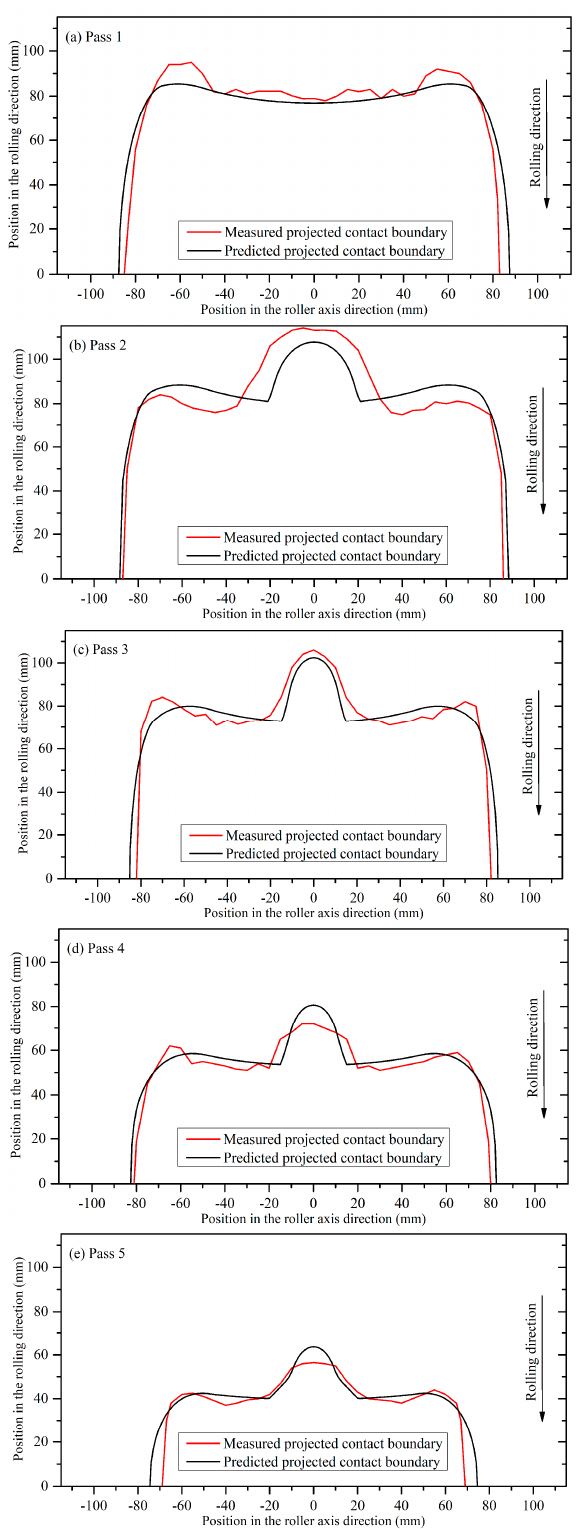
Figure 10. Comparison of the measured and predicted projected tube-roll contact boundary. ( a ) Pass 1, ( b ) Pass 2, ( c ) Pass 3, ( d ) Pass 4, and ( e ) Pass 5. From the comparison, it can be found that the basic characteristic of the contact boundary at the first pass is different from those of the subsequent passes. The starting